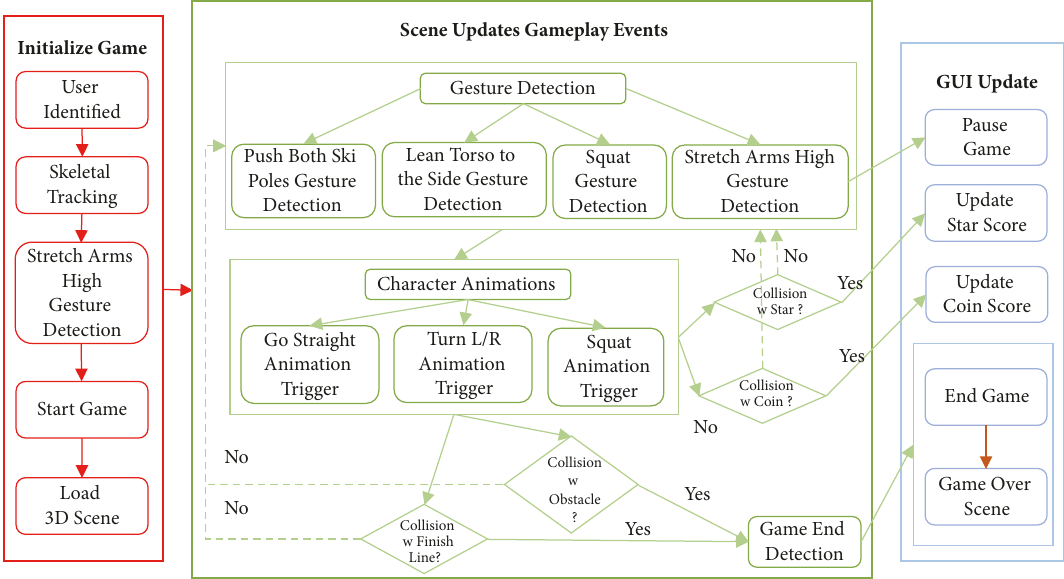
Figure 14: Functional diagram for the Ski game